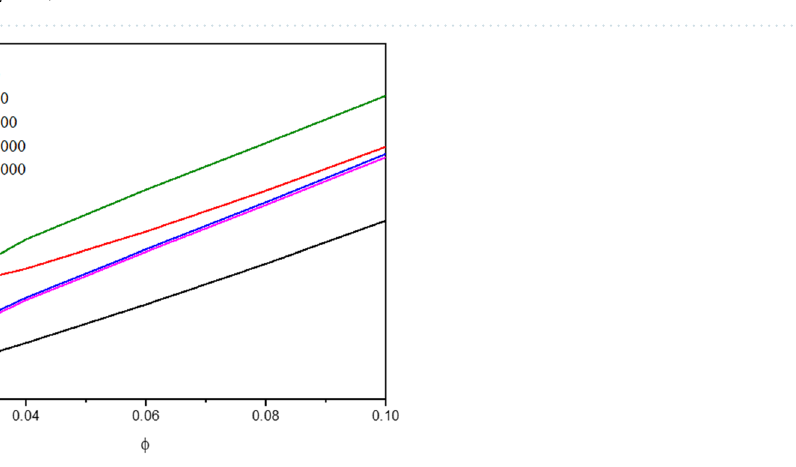
Figure 15. Variation of Nu mf along φ below the changes on the inter-phase heat transfer coefficient H ∗ for a hybrid nanofluid at φ Cu = φ TiO 2 = φ/ 2, B = 0.5, Q = 1, R d = 0.5, Da = 10 − 3 , ε = 0.5, k fs = 1, D = 0.5, k r = 1, Ha =